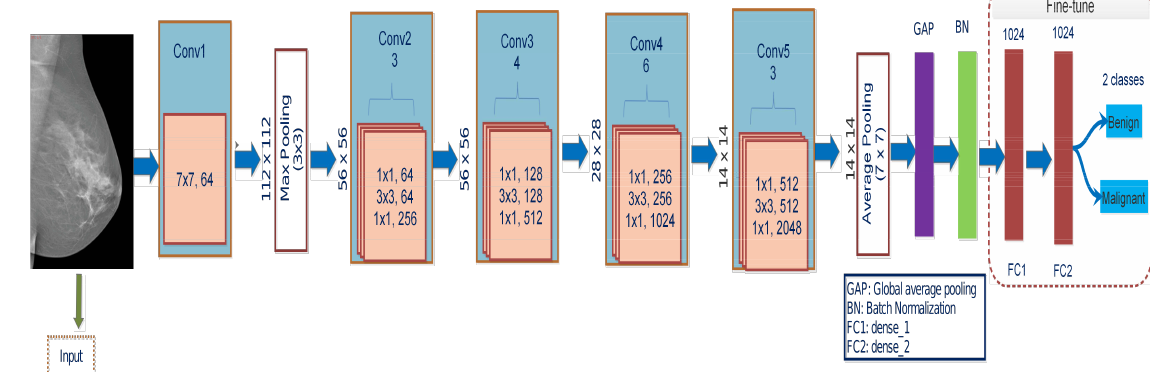
Figure 4. The proposed framework of ResNet50 architecture containing 50 layers. The global average pooling layers (GAP) and batch normalization layer (BN) are added, followed by FC1, FC2, and output